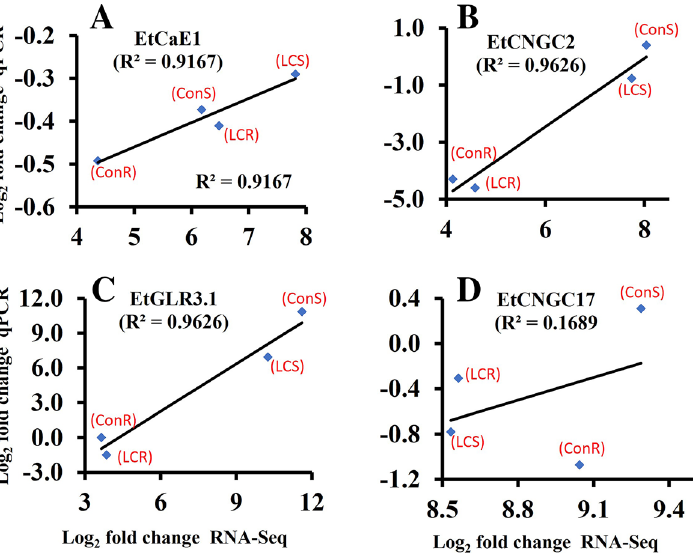
Figure 7. Validation of RNA-seq data by qPCR. Pearson correlation analysis of Log 2 fold changes of DEGs based on RNA-seq and qPCR analysis. Data points and corresponding treatments (ConR, ConS, LCR and LCS) are